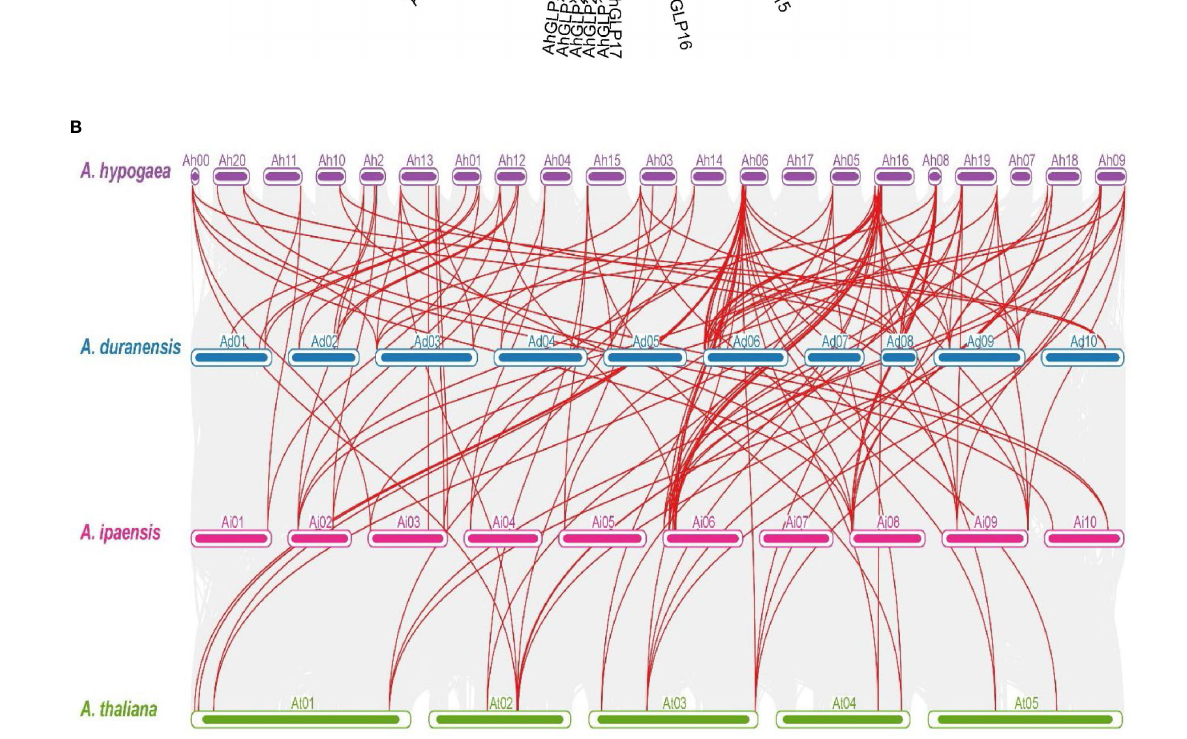
FIGURE 9 (A) Schematic diagram of gene duplication in AhGLPs , red lines indicate the duplicated gene pairs and grey lines in the background represent the duplicated regions among different chromosomes. (B) Synteny analysis among A hypogea , A duranensis , A ipaensis , and A thaliana . Synteny analysis showed key evolutionary relationships of GLPs in diploid and tetraploid peanut species. AhGLPs possessed highly conserved syntenic relationships with other peanut species as compared to Arabidopsis